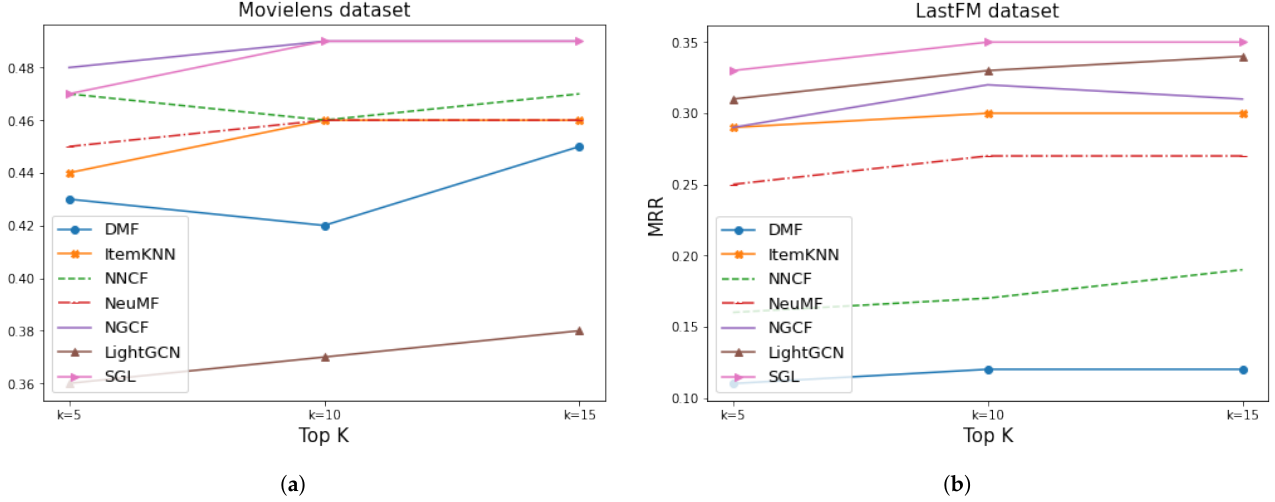
Figure 13. Results of MRR for Movielens and LastFM. ( a ) MovieLens MRR. ( b ) LastFM MRR. Figure 14 shows the HIT measure. From this metric’s view, most of the implemented models showed similar results for MovieLens except LightGCN, which performed consider- ably poorly, although SGL and NGCF obtained the highest values. On the other hand, this metric showed that SGL, LightGCN, and NGCF, the three GNN-based methods, provided a higher HIT for the LastFM dataset.